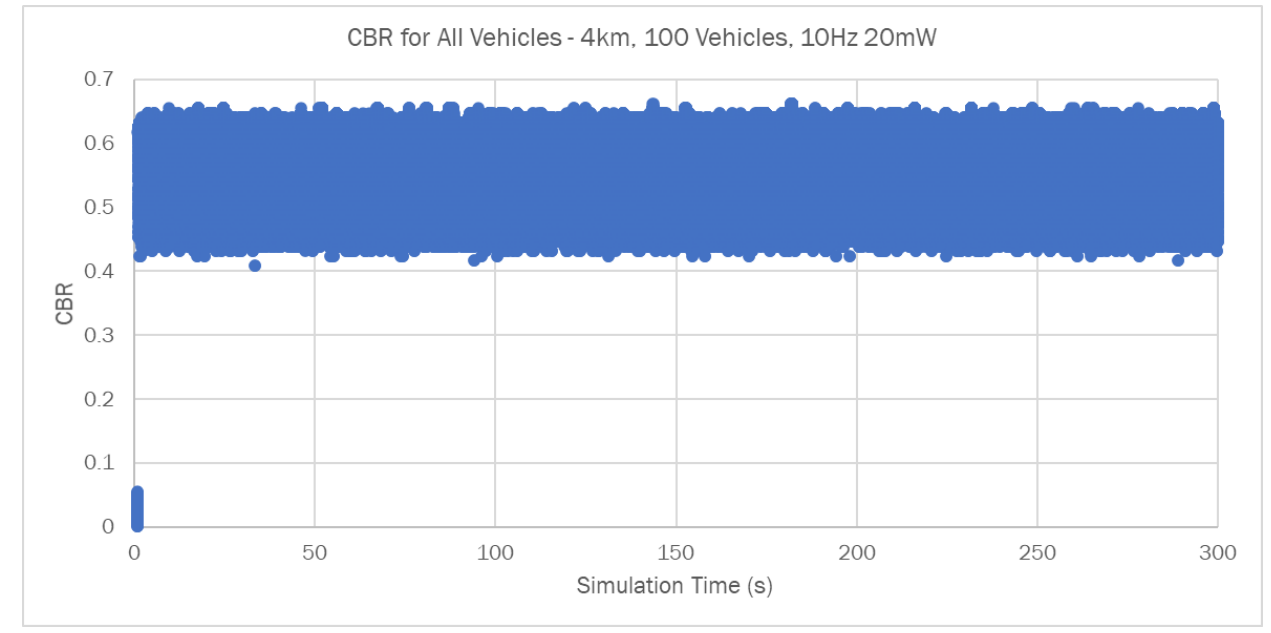
Figure 2. Real time CBR.